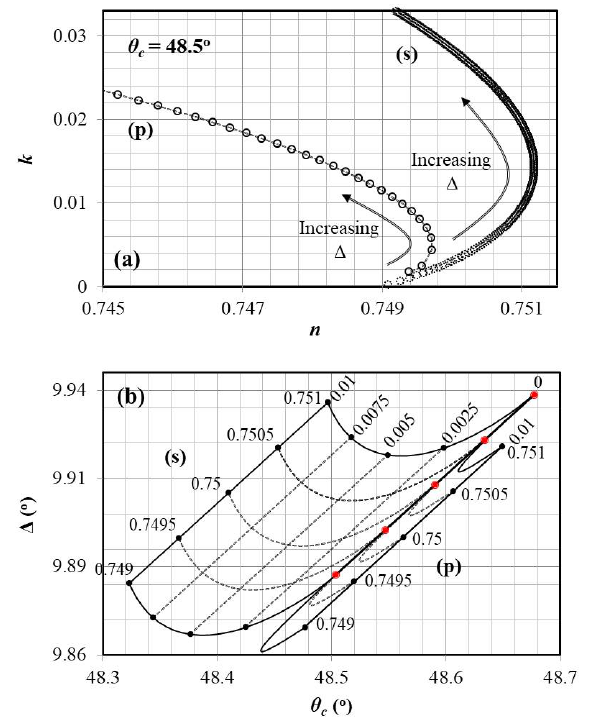
Figure 2. ( a ) Iso- θ c curves in the ( n , k ) plane ( θ c = 48.5 ◦ ) arrows mark the direction of increasing ∆ in steps of 0.001 ◦ , starting from a base ∆ = 9.882 ◦ ( 9.845 ◦ ) for s (p) polarisation. ( b ) Iso- n and iso- k curves in the ( θ c , ∆ ) plane. Parameter n assumes constant values 0.749, 0.7495, 0.75, 0.7505 and 0.751 for both polarisations. Parameter k assumes constant values 0, 0.0025, 0.005, 0.0075 and 0.001 for s polarisation, as well as 0 and 0.01 for p polarisation. The common transparency line ( k = 0) separates the s polarisation grid on the left, from the p polarisation grid on the